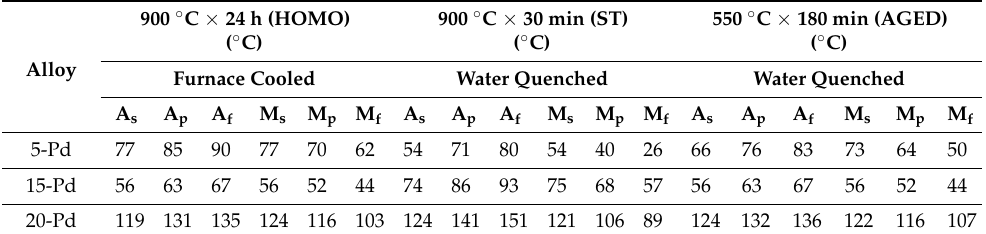
Table 3. Transformation temperatures as measured by DSC of homogenized, solution-treated and aged alloys B. Thermal rate was set to 10 ◦